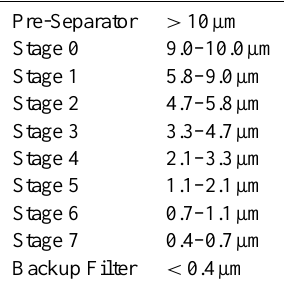
Table 2. Andersen Mark II Cascade Impactor Size